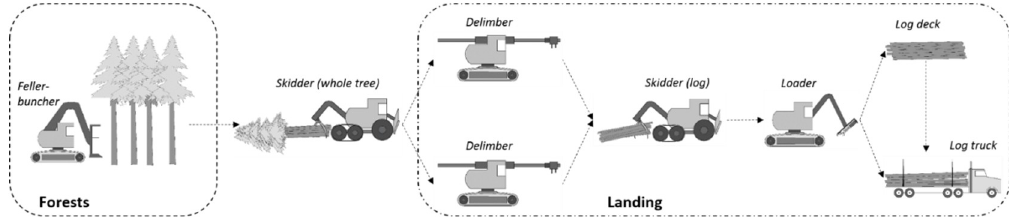
Figure 2. Description of the whole-tree harvesting system used in Colorado State Forest State Park.